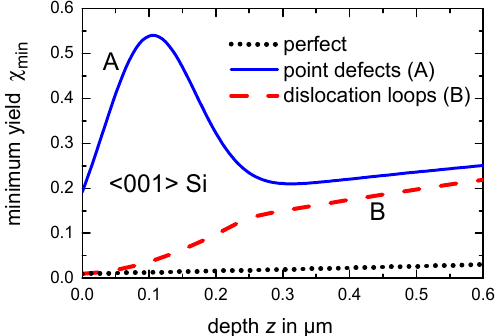
Figure 2. Minimum yield χ min versus depth z calculated for 1.4 MeV He ions and <001> Si with different defect states within the first 0.25 µm: Gaussian distribution of point defect complexes (solid line, A ) and box-like distribution of dislocation loops (dashed line, B ). The χ min ( z ) spectrum of undamaged Si is given as a dotted line for comparison. For details see text.